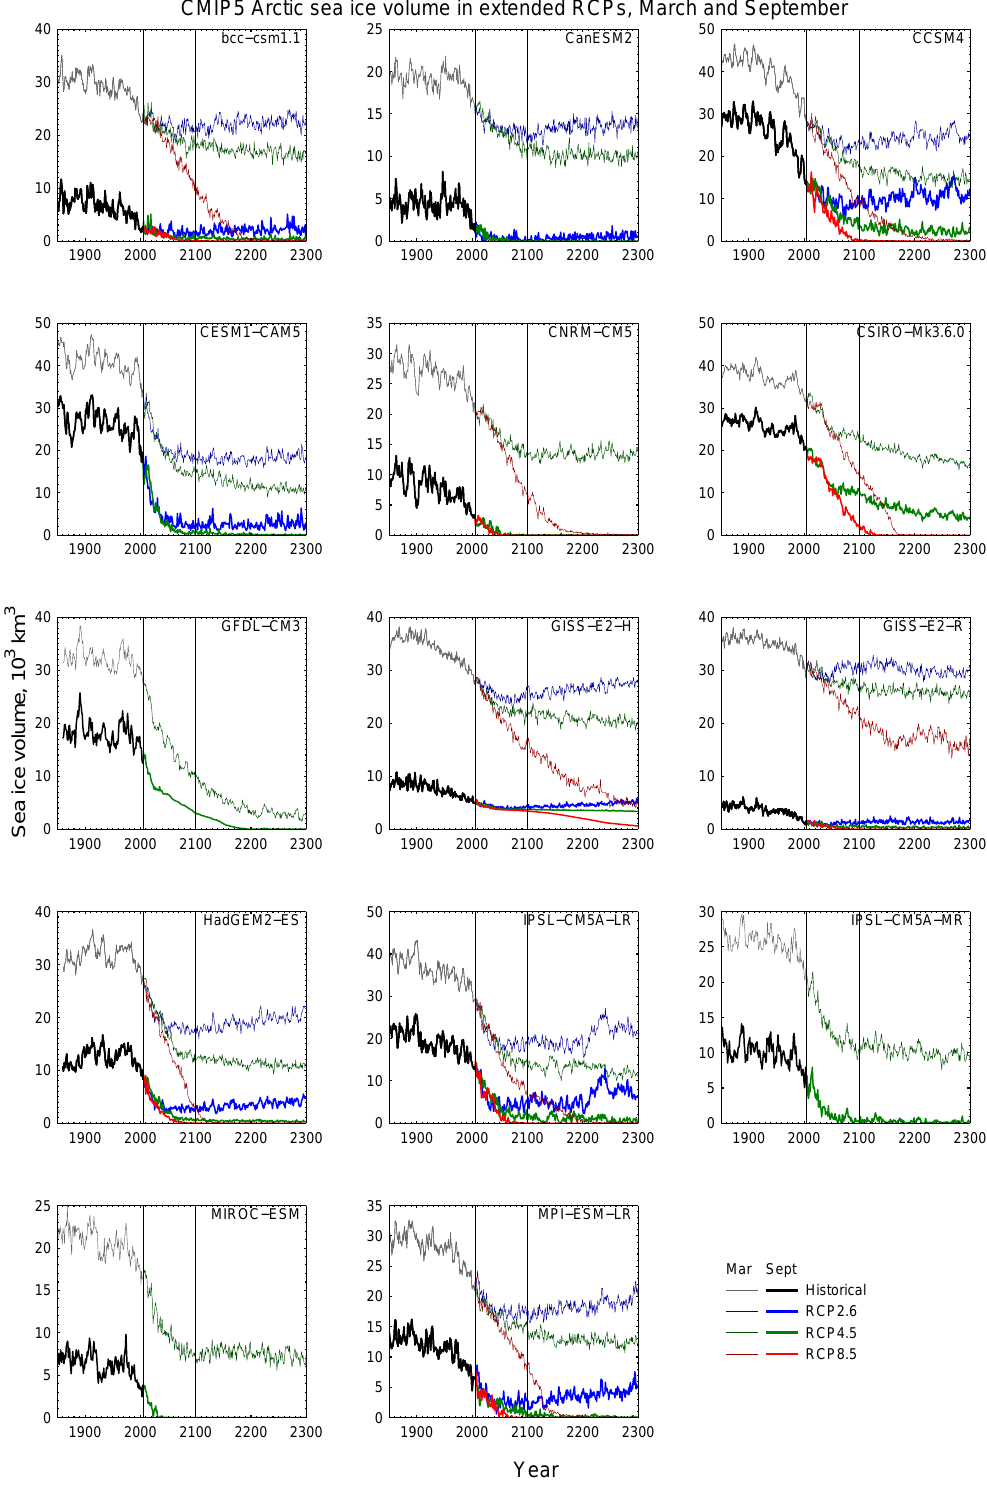
Figure 4. As in Fig. 3, for Arctic sea ice volume, 10 3 km 3 . Fig. 4. As in Fig. 3, for Arctic sea ice volume, 10 3 km 3 .